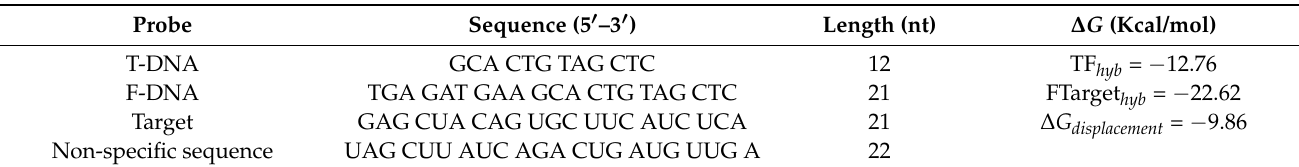
Table 1. Sequence, length and thermodynamic parameters of the DNA probes and RNA targets. TF hyb represents the free energy gained from the partially complementary T-DNA/F-DNA duplex; FTarget hyb is the free energy gained from the fully complementary Target/F-DNA duplex; ∆ G displacement is the free energy gained after T-DNA/F-DNA de-hybridization and Target/F-DNA